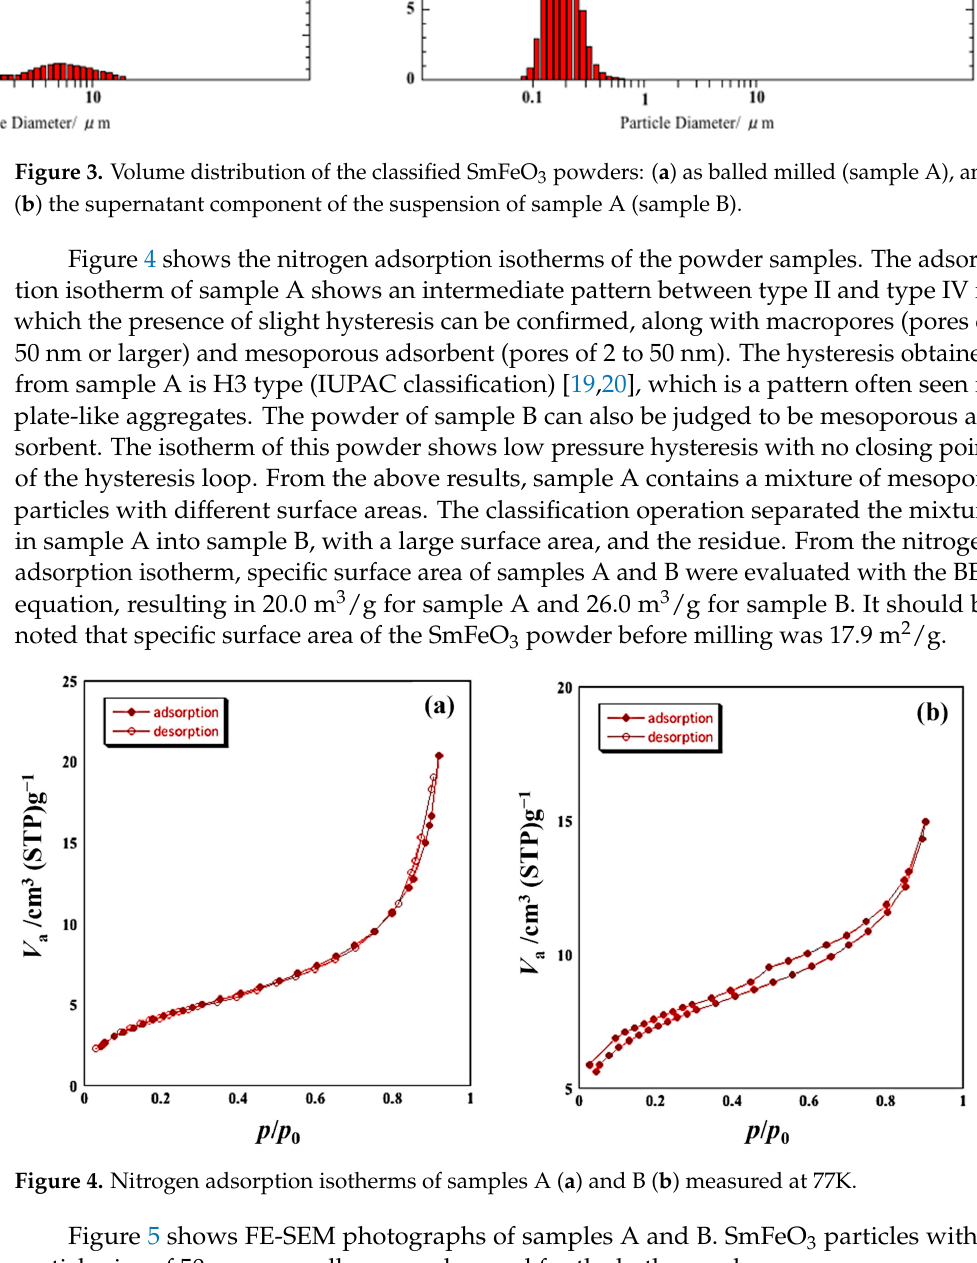
Figure 4. Nitrogen adsorption isotherms of samples A ( a ) and B ( b ) measured at 77K.